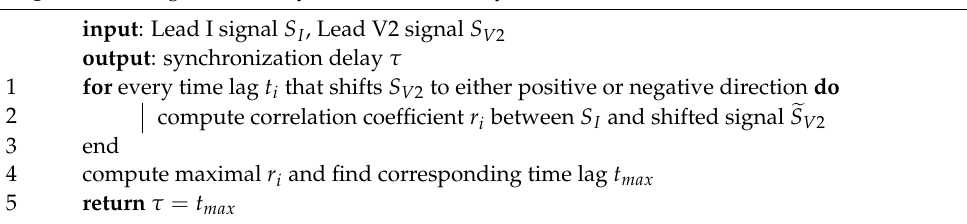
Algorithm 1. Algorithm for synchronization delay